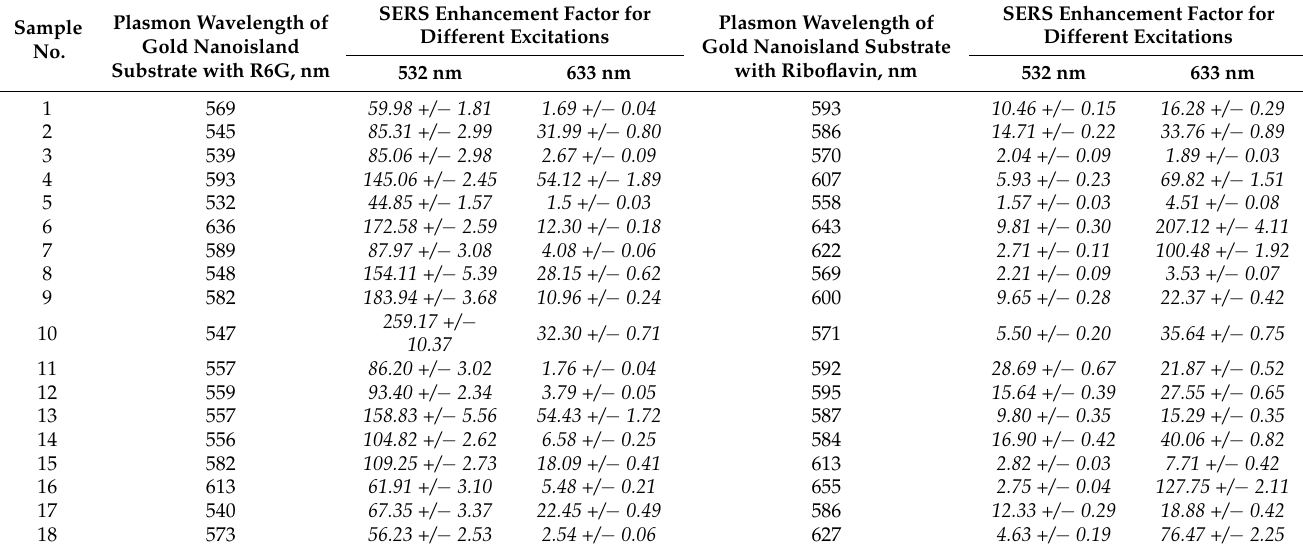
2.75 +/− 0.04 127.75 +/− 2.11